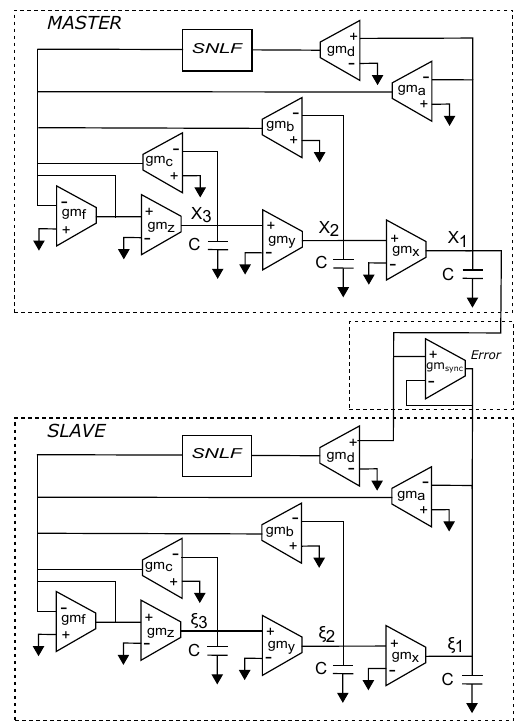
Figure 17. Synchronization of two multi-scroll chaotic attractors implemented with OTAs and with our proposed current mode PWL function described by the block